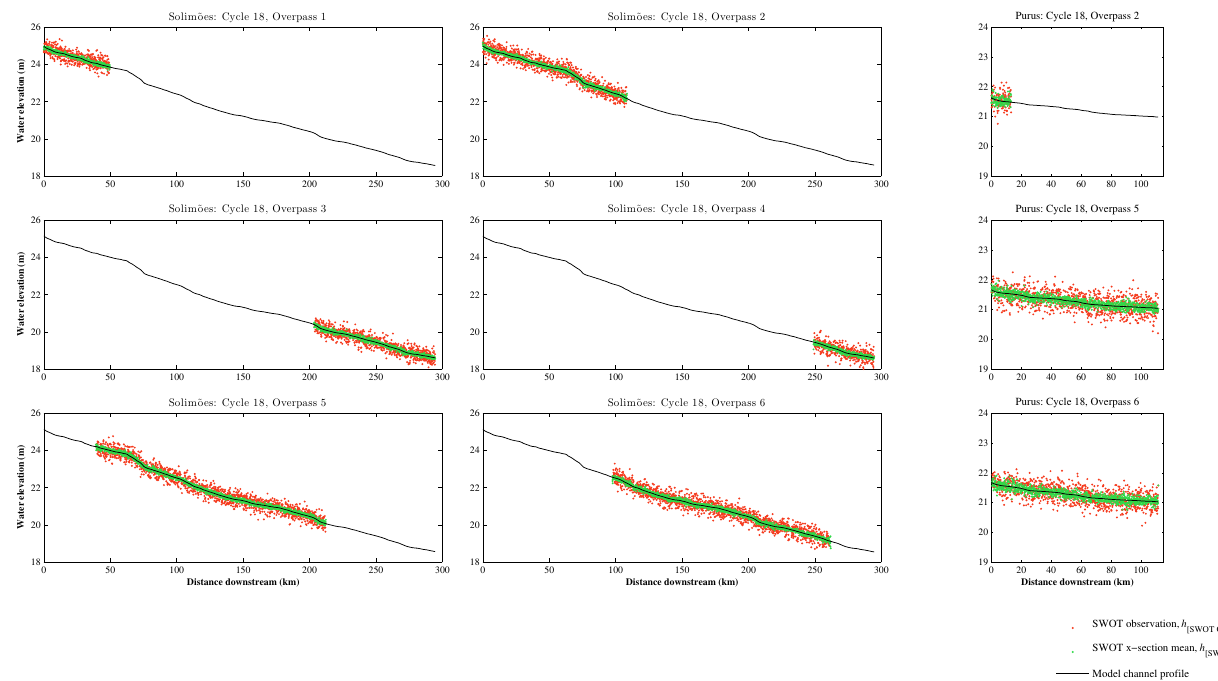
Figure 8. The 2-D heights (Fig. 6) were transferred to 1-D for both the Solimões and Purus by extracting values of h [ SWOTOBS ] along the channel centerline; to reduce errors, averages of cross sections taken perpendicular to the channel centerline were also calculated ( h [ SWOTXS ] ).